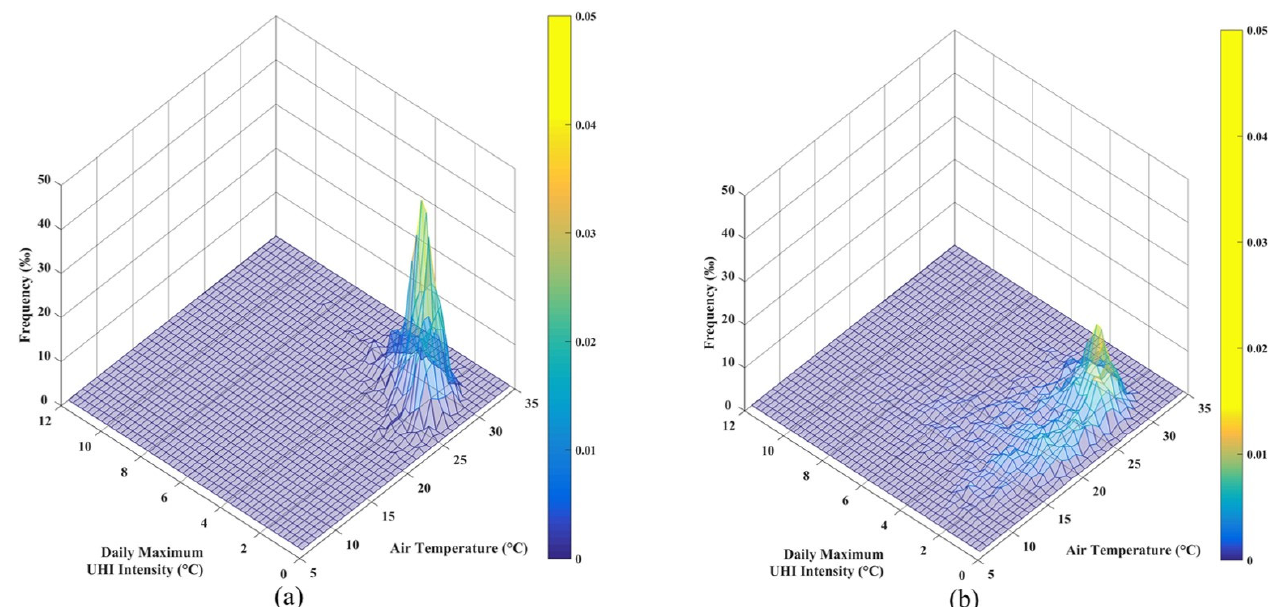
Figure 9. Frequency distribution of UHImax as a function of air temperature (2002–2012, ( a ) summer, ( b ) annual).